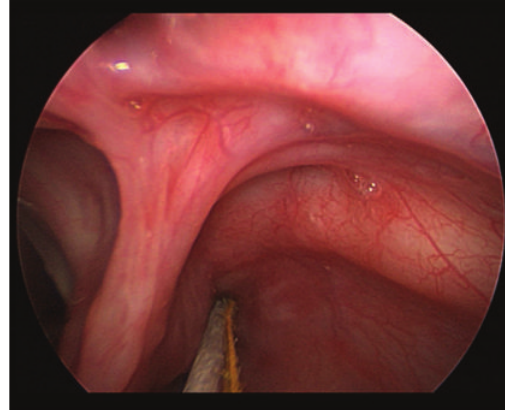
Figure 6: Esophagram (anteroposterior and lateral views) of cervi- cal esophagus with barium swallow demonstrating a slight wide- mouthed outpouching of the right hypopharynx without contrast pooling. There is absence of a fistulous